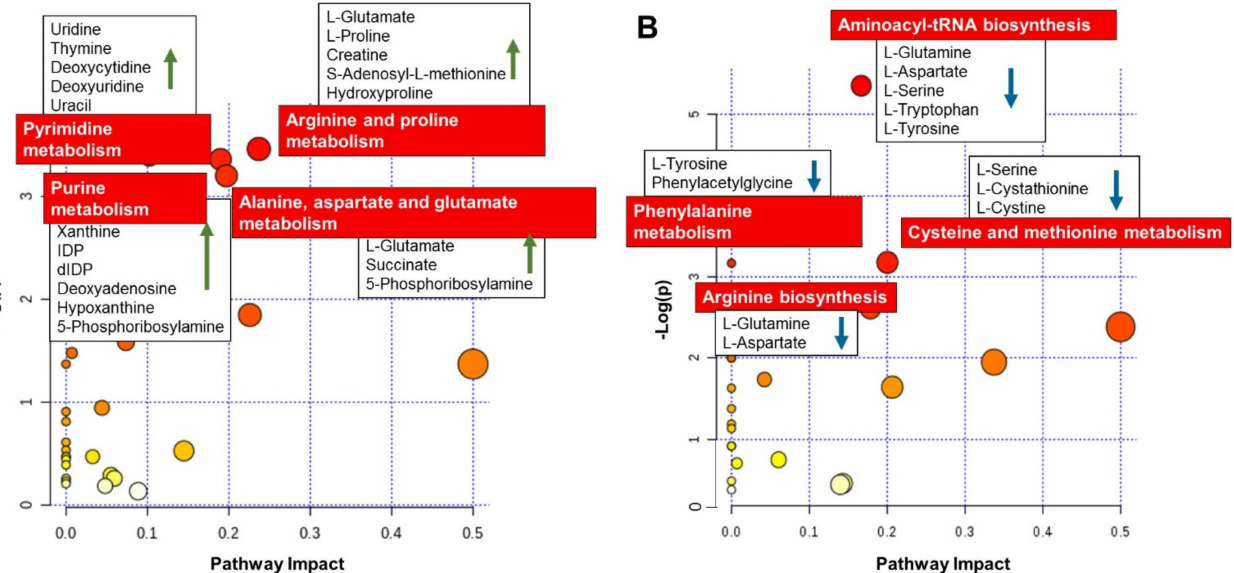
Figure 5. Metabolic pathways of significantly changed metabolites between day 5 embryo culture CM and day 5 embryo culture KSOM. ( A ) Increased metabolites uniquely produced by embryos when exposed to uterine epithelial cells. The graph presents a list of the matched overrepresented pathways for compounds significantly increased in day 5 embryo culture CM, compared to day 5 embryo culture KSOM, arranged by p -values on Y-axis, and pathway impact values on X-axis. The enriched pathways for the 208 increased metabolites identified in the CM group are represented by nodes of different size and color gradient corresponding to the significance of the pathway ranked by impact score (the larger the circle the higher the impact score) and p -value (yellow: higher p -values and red: lower p -values), respectively. The red labels highlight the main pathways. Five of these pathways had a p -value < 0.1 and 16 had pathway impact value higher than 0, which are the cut-off values for relevance. ( B ) Decreased metabolites uniquely produced by embryos when exposed to uterine epithelial cells. Only pathways with p -value < 0.1 were considered significant. Of these pathways, 10 had impact value higher than 0 and 10 had a p value < 0.2. The most significantly affected ( p < 0.1) metabolic pathways are labelled and represented with larger red